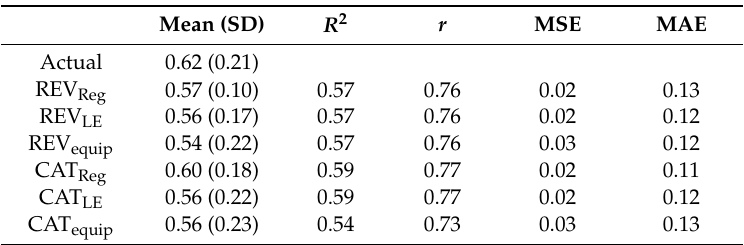
Table 2. Mean (standard deviation (SD)) of actual and estimated EQ-5D Index Scores, R 2 values, correlation coe ffi cients, mean squared errors (MSE), and mean absolute errors (MAE) for models in the spine patient sample ( N = 121).